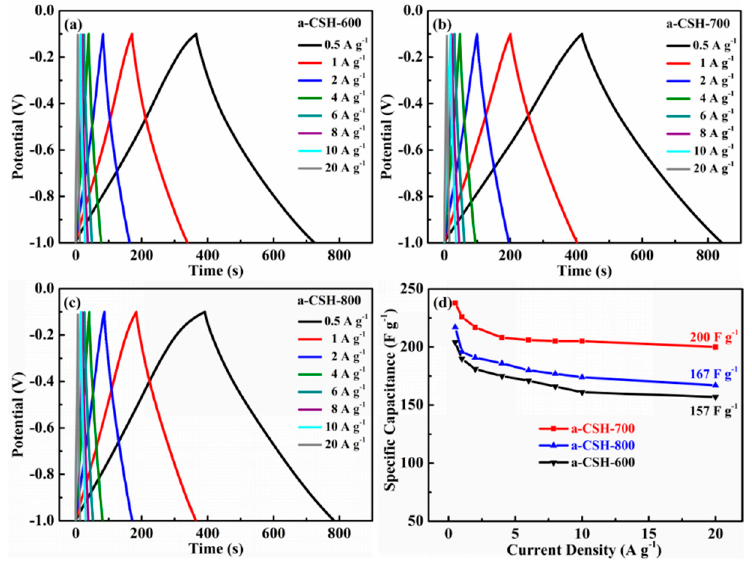
Figure 8. Electrochemical performance characteristics of a-CSHs measured in a three-electrode system in a 6 M KOH electrolyte: galvanostatic charge/discharge (GCD) curves of ( a ) a-CSH-600, ( b ) a-CSH-700, and ( c ) a-CSH-800 at different scan rates. ( d ) Specific capacitances at different current densities. Table 3. Electrochemical performance of biomass derived porous carbons.